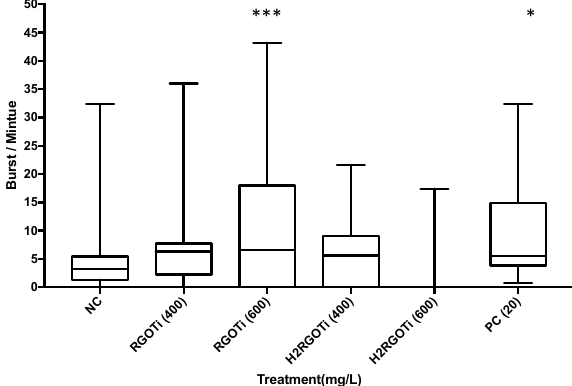
Figure 4. Assessment of potential neuro / muscular toxicity at 24-hpf by locomotion / tail coiling assay. The plot represents the average tail coiling (burst / min) measured by DanioScope software. Twenty-five embryos were used per each concentration. One-way ANOVA was used to compare the differences between groups. n = 25. (*) = p < 0.05; (***) = p < 0.001.